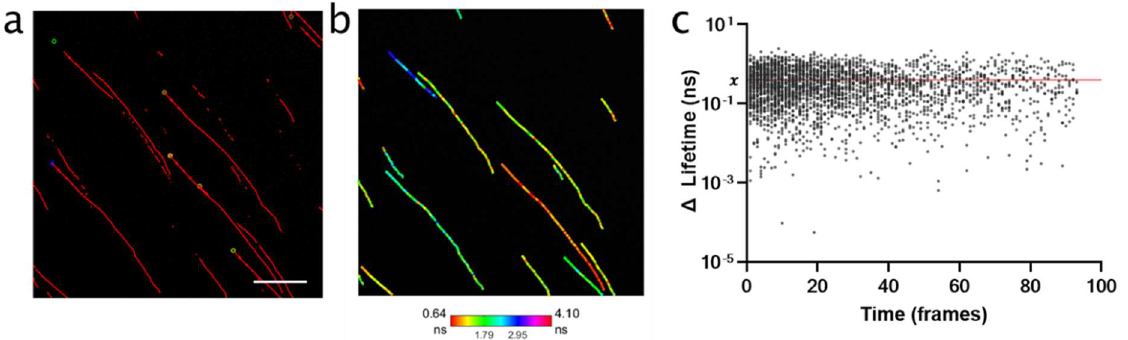
Figure 3. Tracking of 30 nm nanoparticles embedded in 3% agarose to define frame-frame variance (∆ lifetime) within known trajectories. ( a ) Trajectories of 30 nm SiNP defined in DiaTrack, across 100 frames (frame rate 2.62 s), representative of n = 2 (with t = 3 images per biological replicate). Scale bar, 25 μm. ( b ) Trajectories from ( a ) with pixel specific lifetime overlay. ( c ) The frame-to-frame absolute ∆ lifetime calculated from tracking data (sum of >2200 ∆ lifetimes) which were used to define an average threshold at x = 0.39 ns (red line).